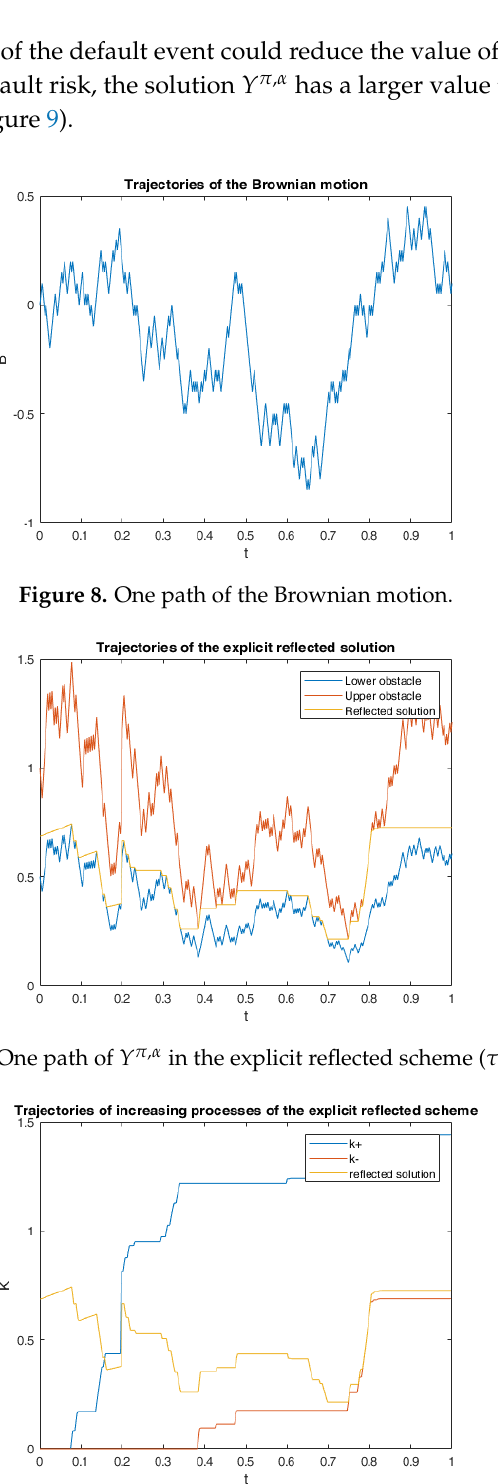
Figure 10. One path of the increasing processes in the explicit reflected scheme ( τ =